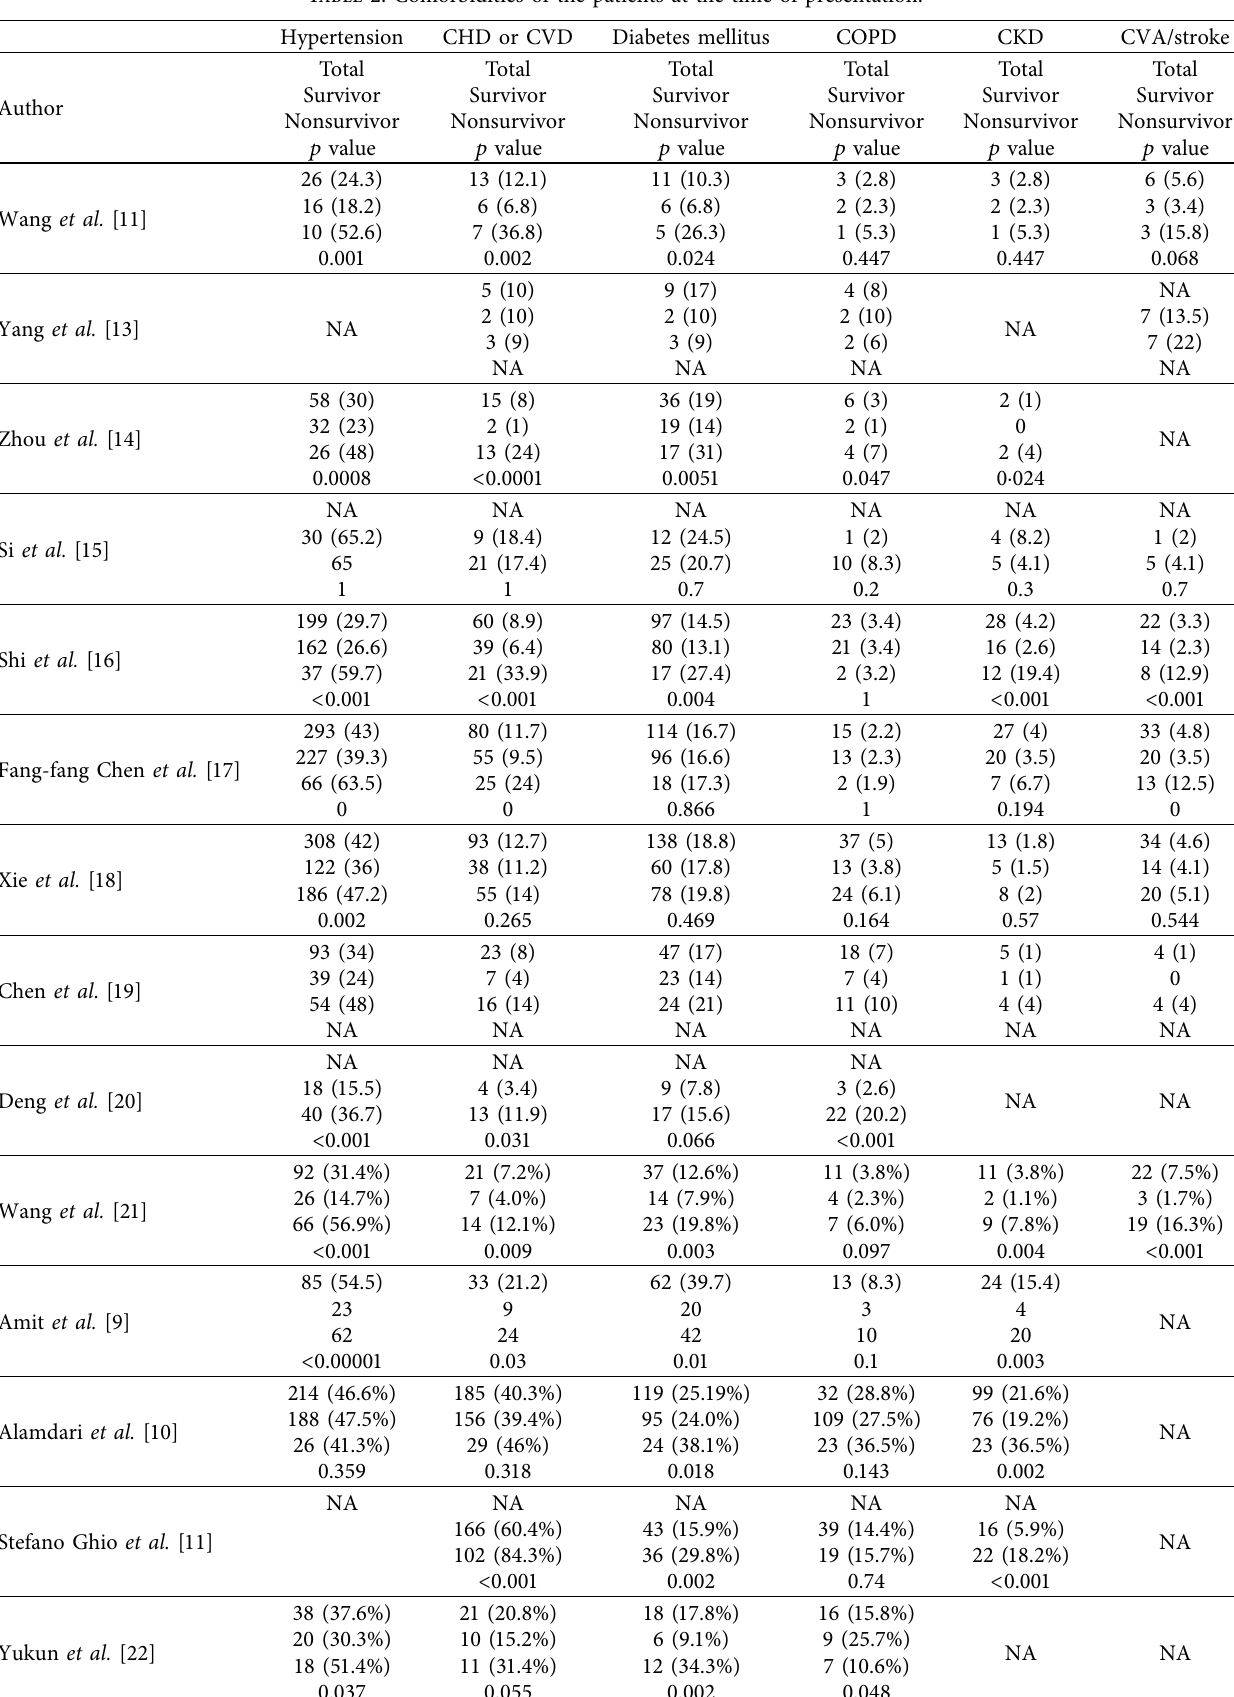
Table 2: Comorbidities of the patients at the time of